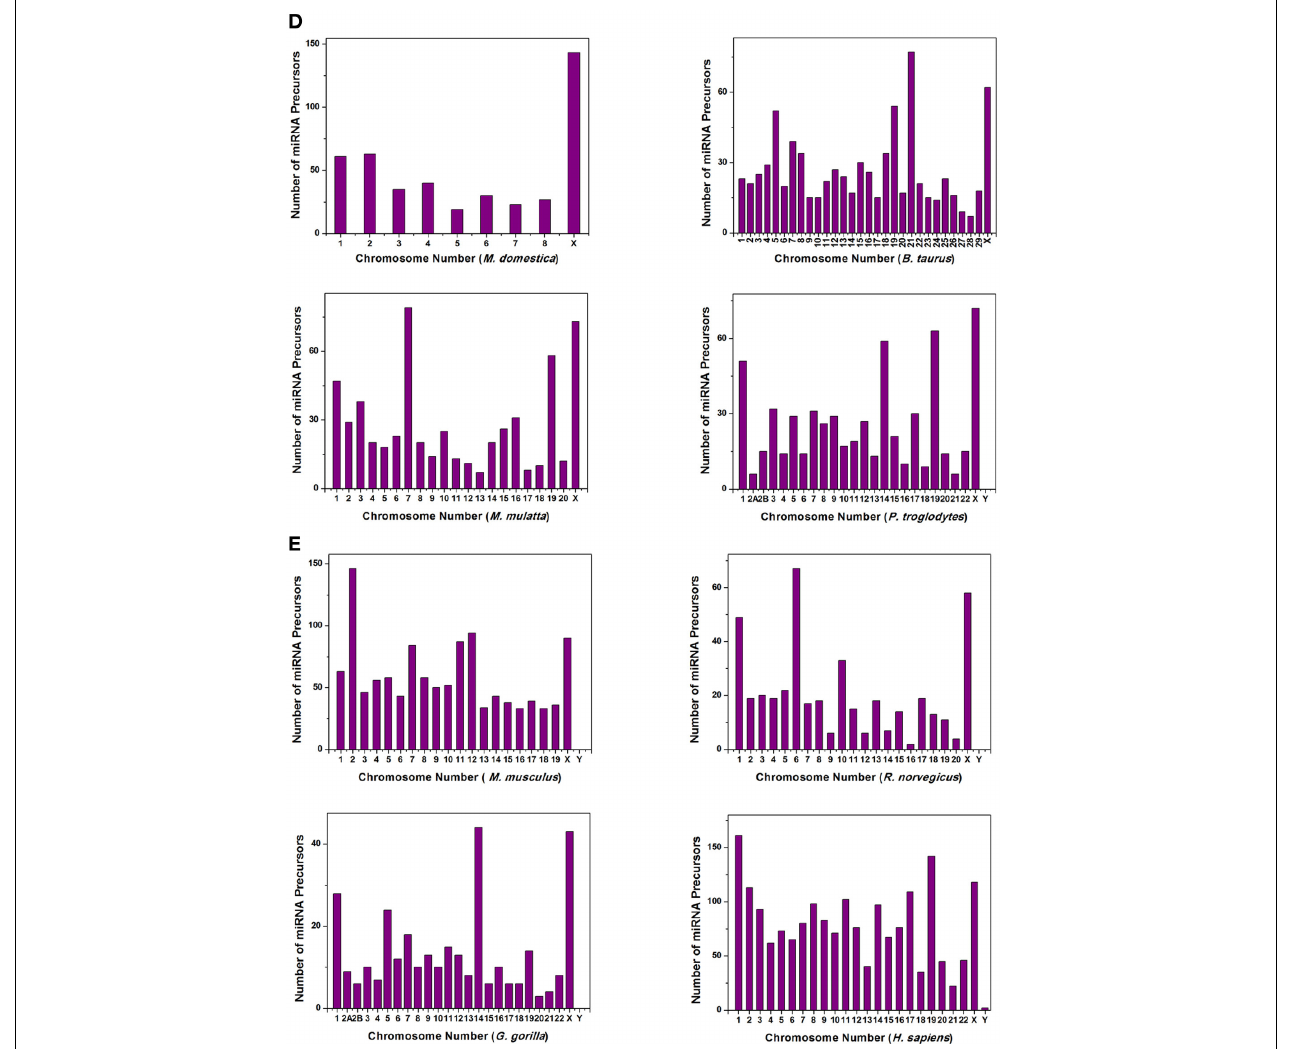
FIGURE 2 | The histogram represents the variation of miRNA precursors (from miRBase) in different chromosomes of species (A) S. mansoni , C. elegans , D. melanogaster , C. intestinalis ; (B) A. carolinensis , G. gallus ,